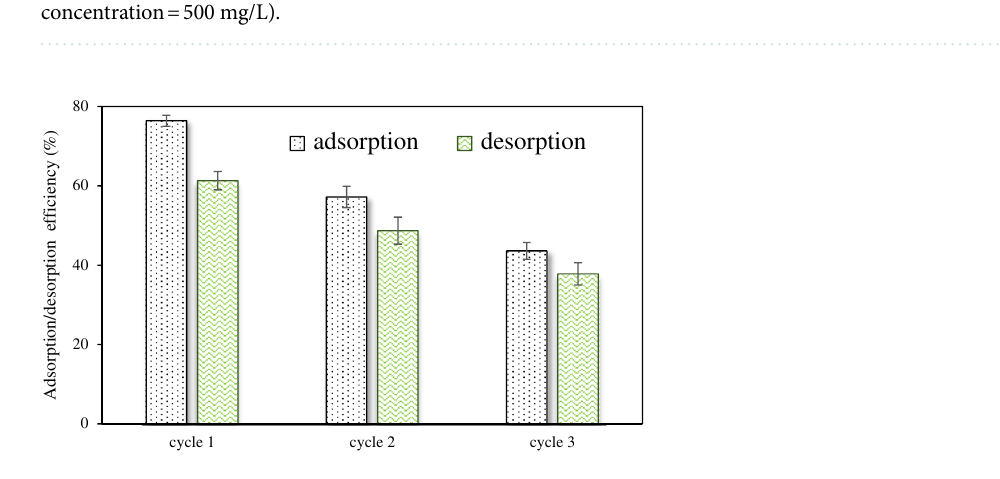
Figure 7. Adsorption–desorption and regeneration studies of